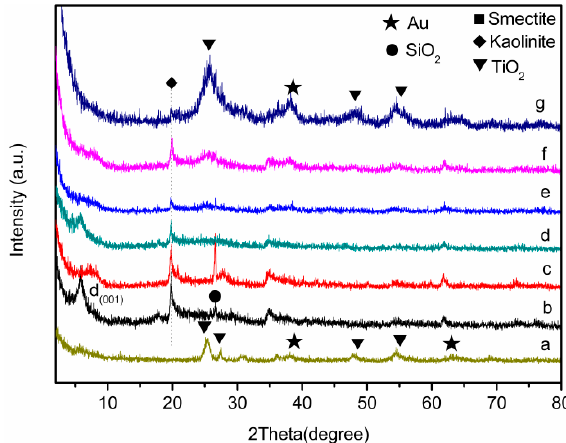
Figure 1. X-ray diffraction (XRD) patterns of the samples: ( a ) Au/TiO 2 ; ( b ) Na-ABen; ( c ) Au/Na-ABen; ( d ) Ti-Na-ABen; ( e ) Au/Ti-Na-ABen; ( f ) Au-Ti/Na-ABen; ( g ) Au-Ti-Ce/Na-ABen. Table 2. The 2 θ and d(001) spacing of the samples.